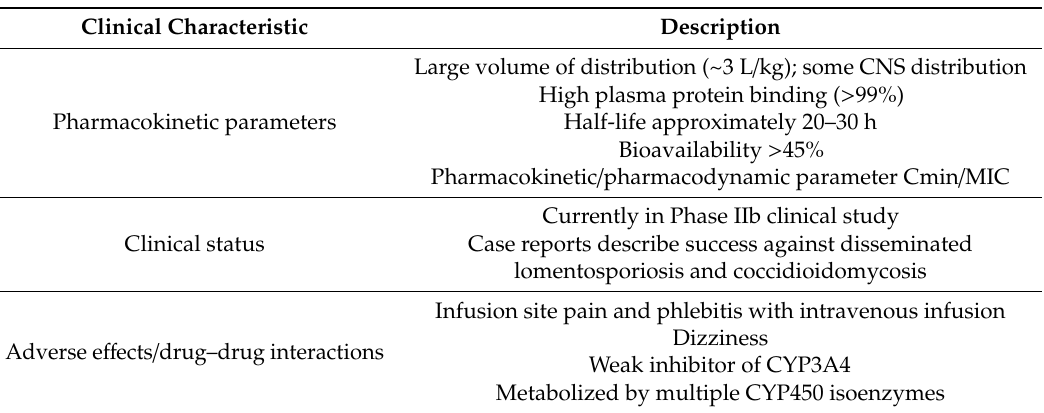
Table 2. Clinical characteristics of olorofim